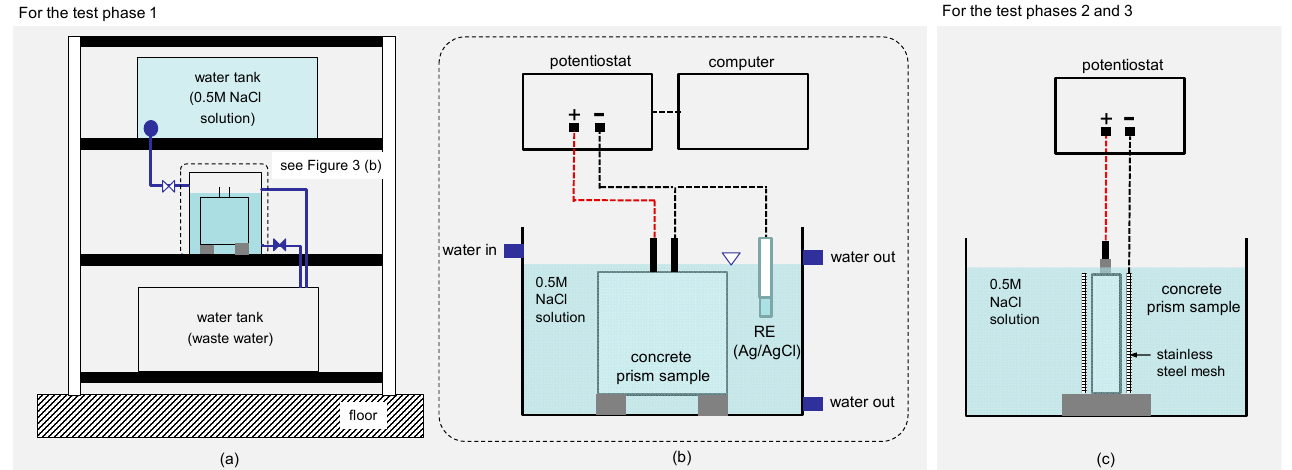
Figure 3. Illustration of test setups for the accelerated corrosion test: ( a , b ) the test setup for the wetting-and-drying cycles for the test phase 1, and ( c ) test setup for the impressed current technique for the test phases 2 and 3.